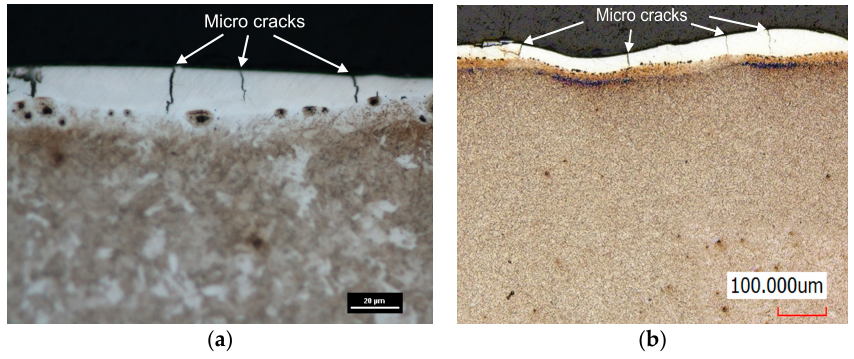
Figure 12. Metallographic structure showing micro cracks in the white layer for the machining parameters: ( a ) I c = 24 A, t on = 150 µs, U c = 25 V; and ( b ) I c = 14 A, t on = 250 µs, U c = 25 V.